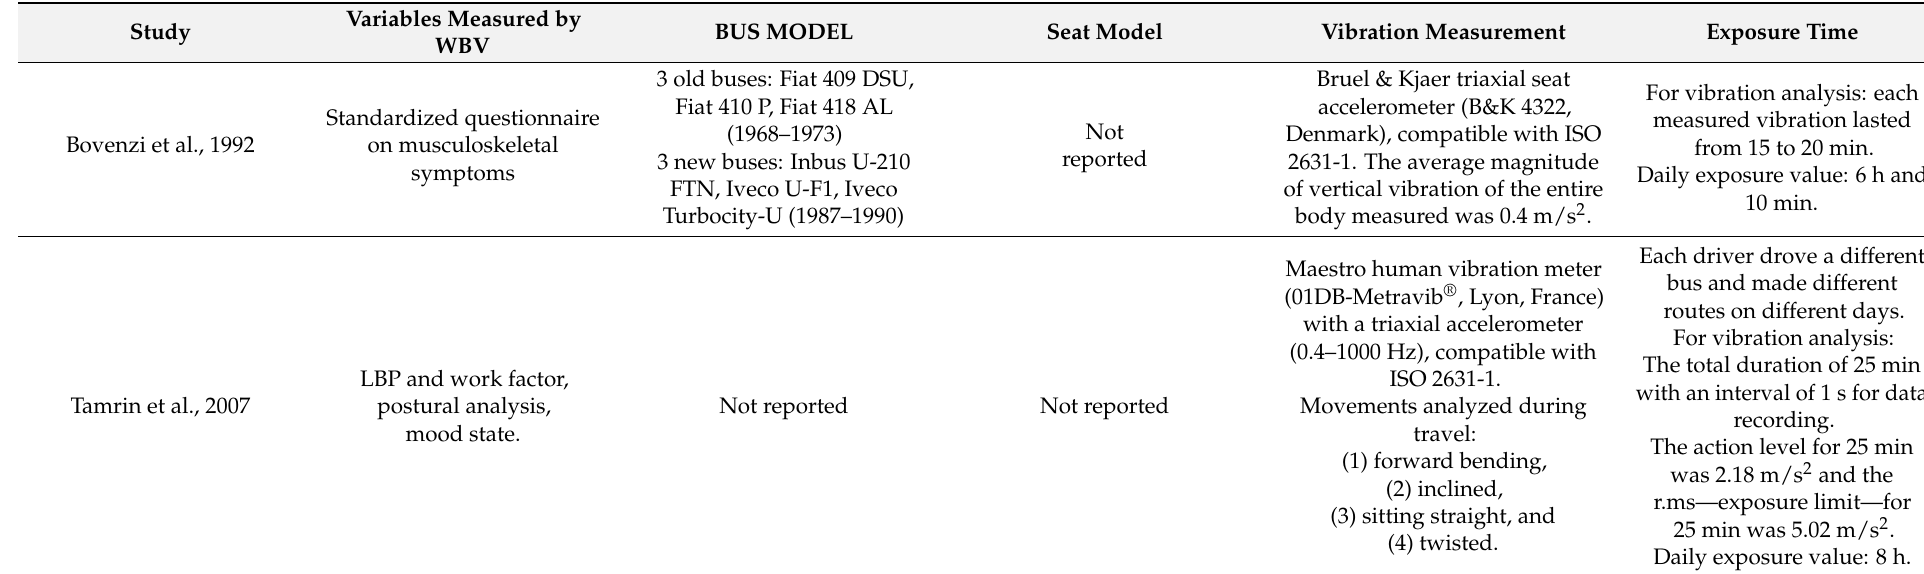
Table 2. Characteristics of mechanical vibration